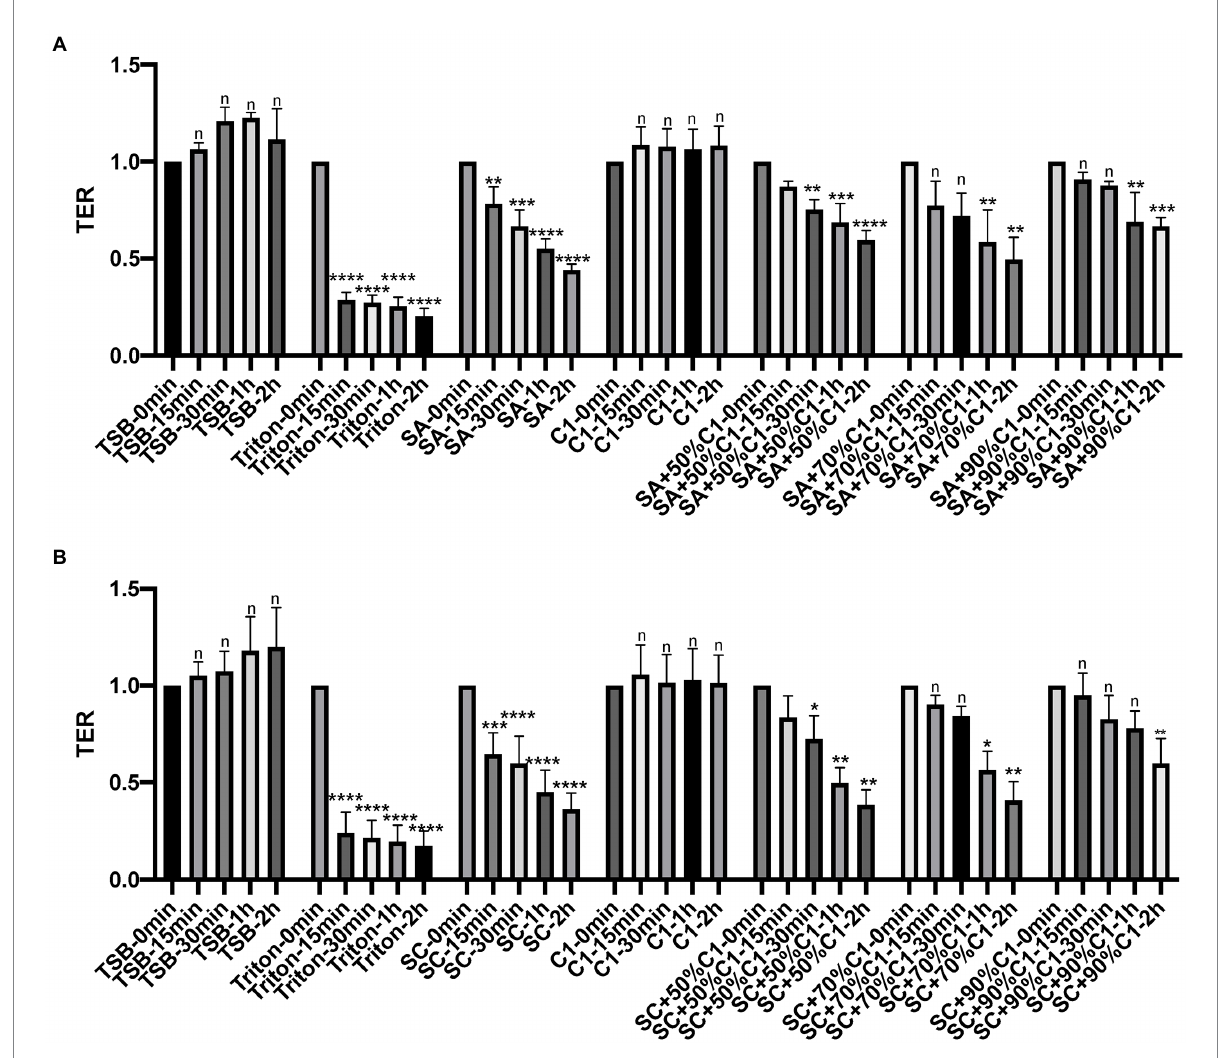
FIGURE 2 Corynebacterium accolens cell-free culture supernatants delay with S. aureus cell-free culture supernatants induced Transepithelial electrical resistance (TER) reduction. TER of HNEC-ALI was measured at 0 mins, 15 mins, 30 mins, 1 h and 2 h, following exposure to C. accolens cell-free culture supernatants, cell-free culture supernatants from the co-cultured C. accolens - S. aureus in different ratio and cell-free culture supernatants of S. aureus ATCC strain [(SA) A ] or a clinical isolate of S. aureus [(SC) B ]. TSB served as the negative control and Triton treatment as the positive control. Experiments were performed in triplicates. The significance was determined by comparing time point at 15 mins, 30 mins, 1 h and 2 h with time 0 min. * p < 0.05, ** p < 0.01, *** p < 0.001, **** p < 0.0001. n, no significance